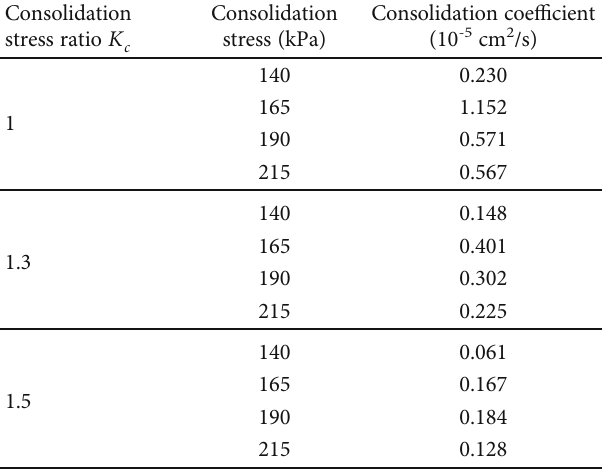
Table 5: Calculated value of consolidation coe ffi cient. Consolidation stress ratio K